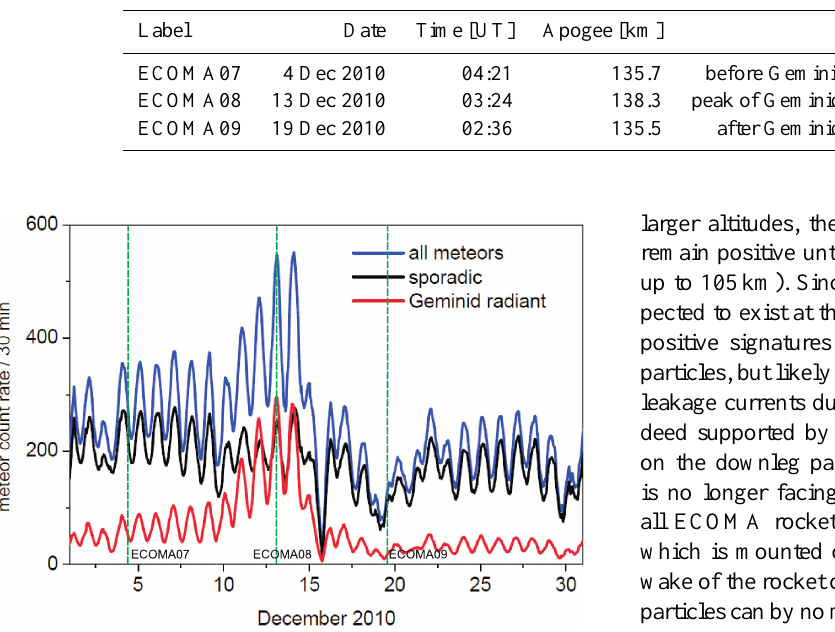
Table 1. Date, time and launch conditions during ECOMA-2010.